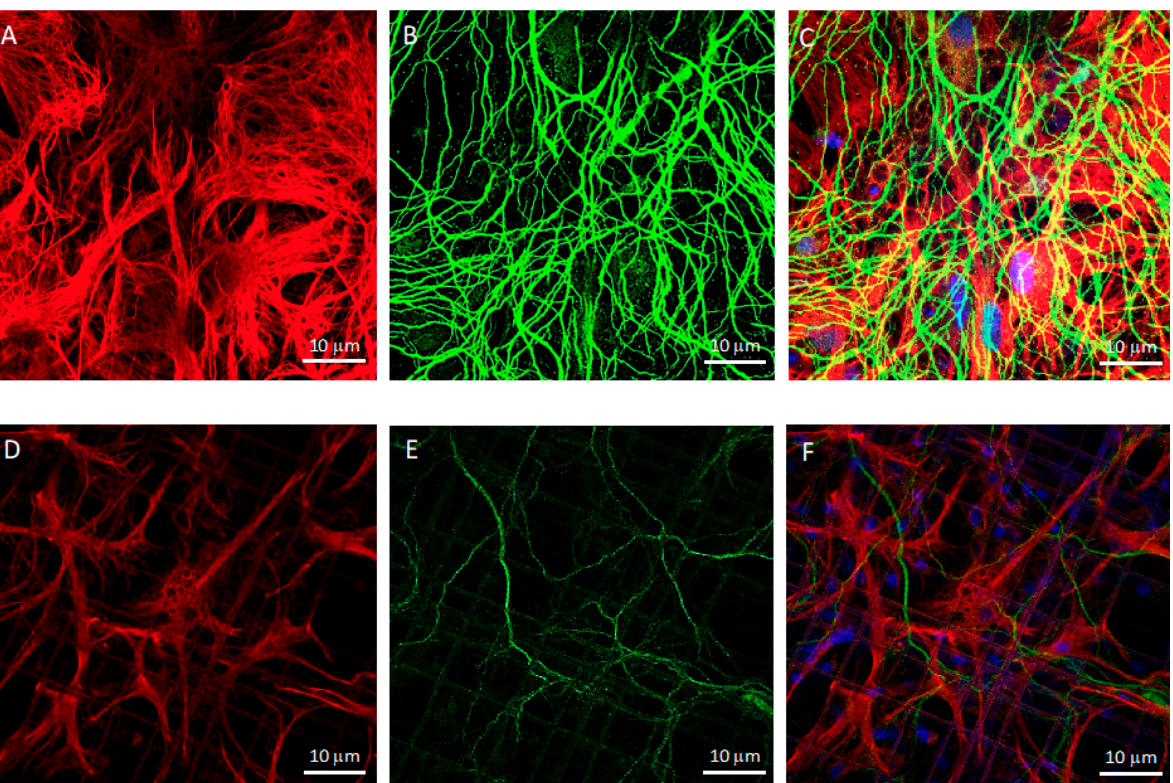
Figure 2. Confocal microscopy of DIV21 hippocampal astrocyte and neuron co-cultures in 2D flat culture and in the 3D synthetic microscaffold Nichoid. ( A – C ) 2D co-cultures formed by ( A ) hippocampal astrocytes, marked with GFAP in red, and ( B ) hippocampal neurons, marked with MAP2 in green. Nuclei were stained with Hoechst, in blue. ( D – F ) Co-culture in the 3D Nichoid formed by ( D ) hippocampal astrocytes, marked with GFAP in red, and ( E ) hippocampal neurons, marked with MAP2 in green. Nuclei were stained with Hoechst, in blue. Images were taken with a 100× (oil immersion) objective. Scale bar of 10 μ m.